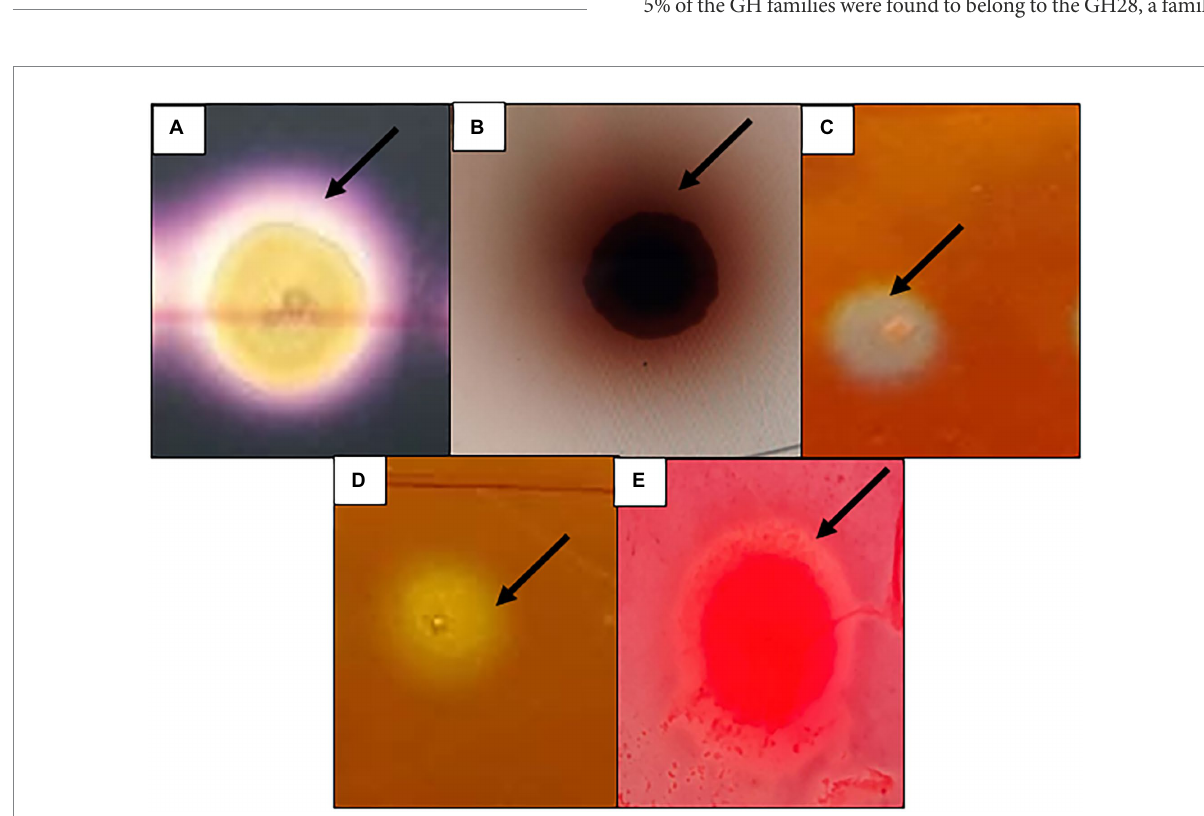
FIGURE 1 Functional screening of the metagenomics library constructed from Ethiopian soda lakes showing positive for (A) Amylase, (B) β -glucosidase, (C) Cellulase, (D) Pectinase, (E)